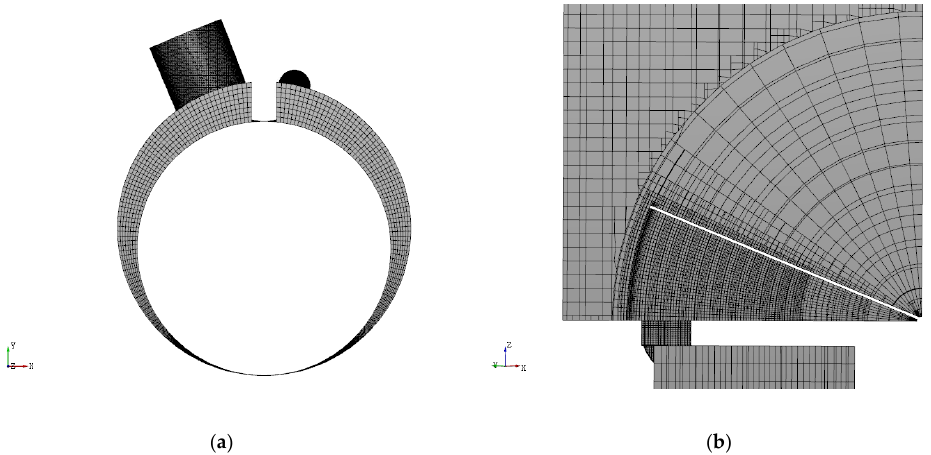
Figure 2. Mesh type and distribution: ( a ) meshes inside cylinder, ( b ) meshes beneath and above reed valve.